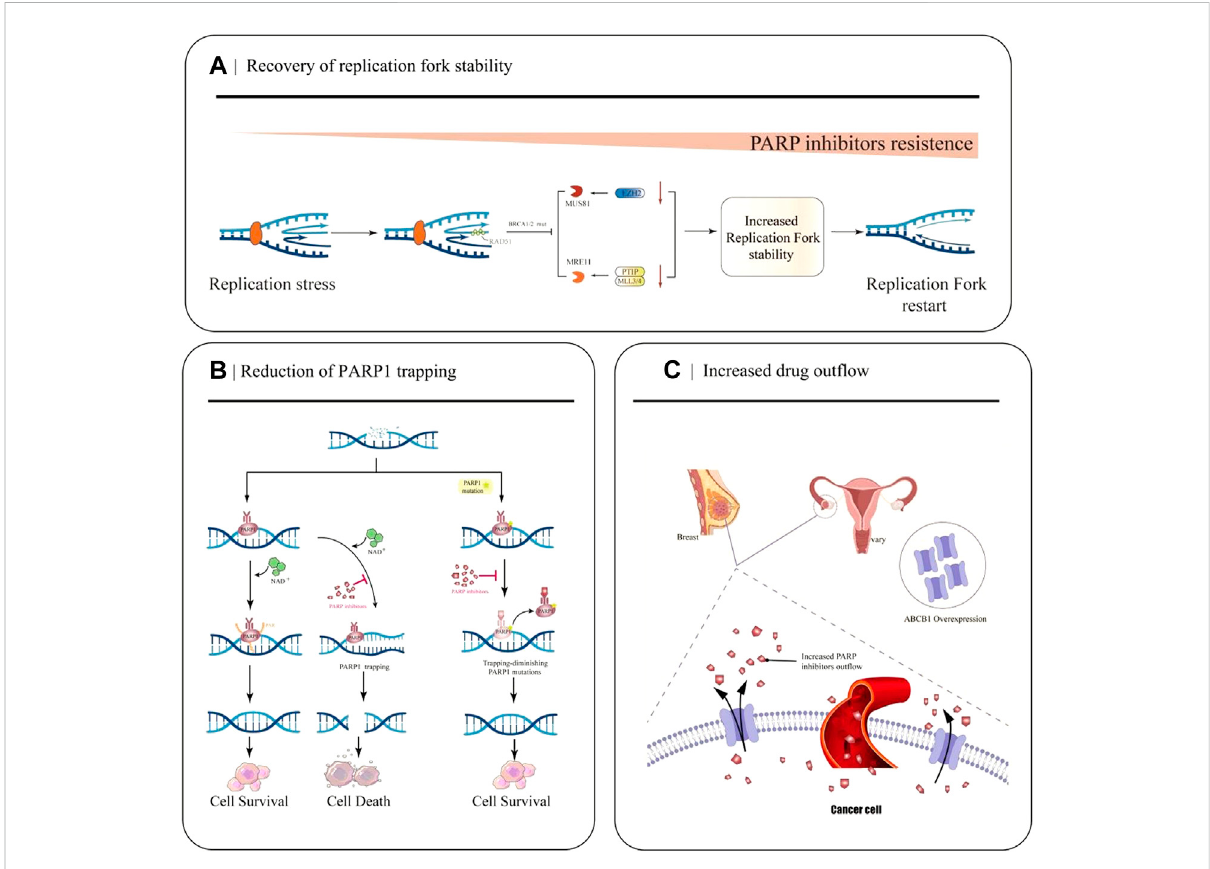
FIGURE 2 Partial mechanisms of PARP inhibitor resistance in cancer. (A) Restoration of replication fork stability leads to PARP inhibitor resistance. When EZH2 or MLL3/4-PTIP is de fi cient, MUS81 and MRE11 recruitment fails, the replication fork is less attacked, and the replication fork is stable. (B) DecreasedPARP1trappingcontributestothedevelopmentofPARPinhibitorresistance.PARPinhibitorsreducethecatalyticactivityofPARP1,sothat PARP remains bound to DNA and cannot undergo subsequent repair. PARP1 mutations reduce PARP capture. (C) Increased drug ef fl ux mediated by ABCB1 overexpression leads to a decrease in effective concentration in cancer cells and increased resistance to